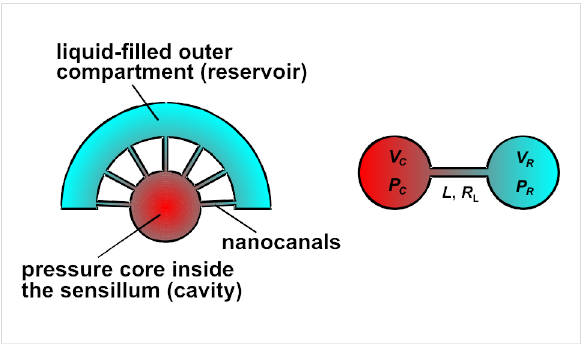
Figure 11: Left: model of the pressure core in the sensillum connected by nanocanals with the outer compartment; right: calculation model for pressure compensation between the core (cavity, volume V C , pres- sure P C ) connected by a canal (length L , radius R L ) with a reservoir (volume V R , pressure P R ) and P C > P R